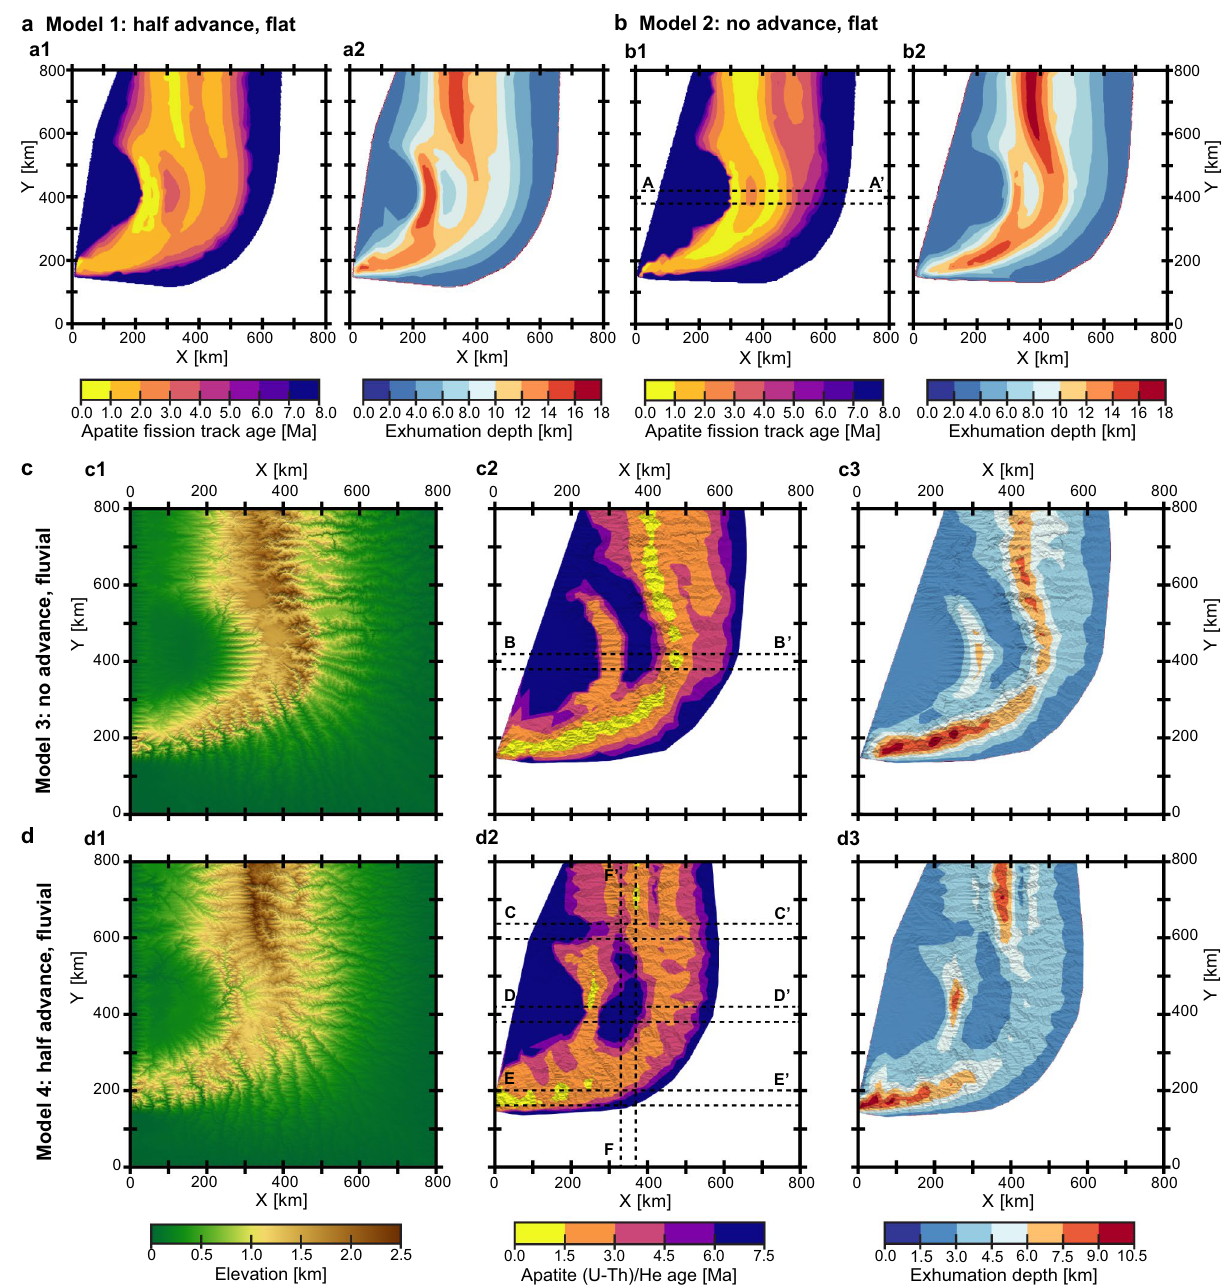
Figure 5. Predicted cooling ages, exhumation depths, and surface topography (shown only for fluvial erosion scenarios) after 6 Myr modelling time for ( a ) model 1 (total erosion; half upper plate advance); ( b ) model 2 (total erosion; no upper plate advance); ( c ) model 3 (fluvial erosion; no upper plate advance); and ( d ) model 4 (fluvial erosion; half upper plate advance). The apatite fission track (AFT) ages (closure temperature T c is 120 ℃ ) are shown for the total erosion models (panels “a” and “b”) because the rock uplift rates in these experiments are too high to produce much variance in the predicted apatite (U-Th)/He (AHe) ages (T c is 70 ℃ ). In contrast, the latter are shown for the fluvial erosion cases (panels “c” and “d”), which are characterized by lower vertical velocities at the surface. Since the resulting thermochronological ages are determined not only by the kinematics of the exhumation paths but also by the evolving temperature field within the model, the distributions of predicted cooling ages are complemented by the exhumation depths, which are not affected by thermal processes. Note, however, that because the experiments begin with a laterally uniform temperature structure, the patterns of exhumation depths and predicted cooling ages (as well as rock uplift rates; see Figs. 3, 4) are quite similar. The 40-km swath cross-sections A-A’, B-B’, C–C’, D-D’, E-E’, and F-F’ marked here by dashed lines, are shown in Fig.